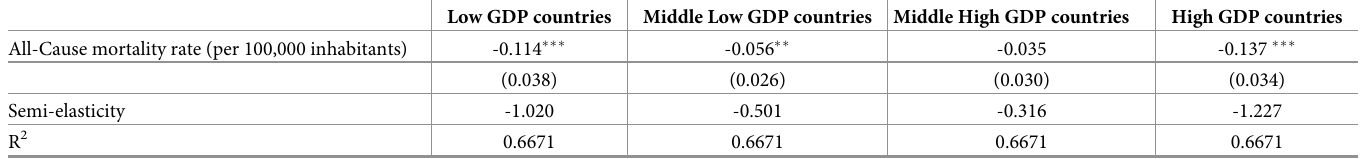
Table A3. The effect of mortality/DALYs on GDPpc growth. Long-Run Growth Regression. Effects by World Bank Country Income Group.